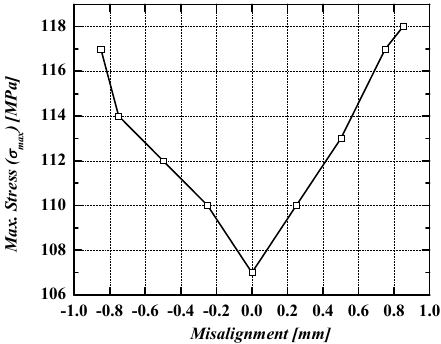
Figure 5. Maximum stress intensity for each misalignment condition.